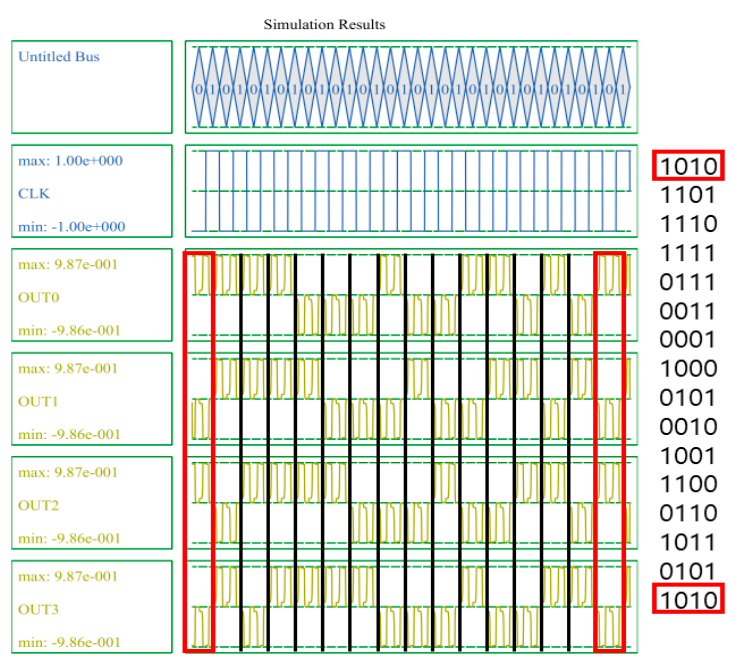
Figure 18. Simulation result of the proposed 4-bit LFSR structure.